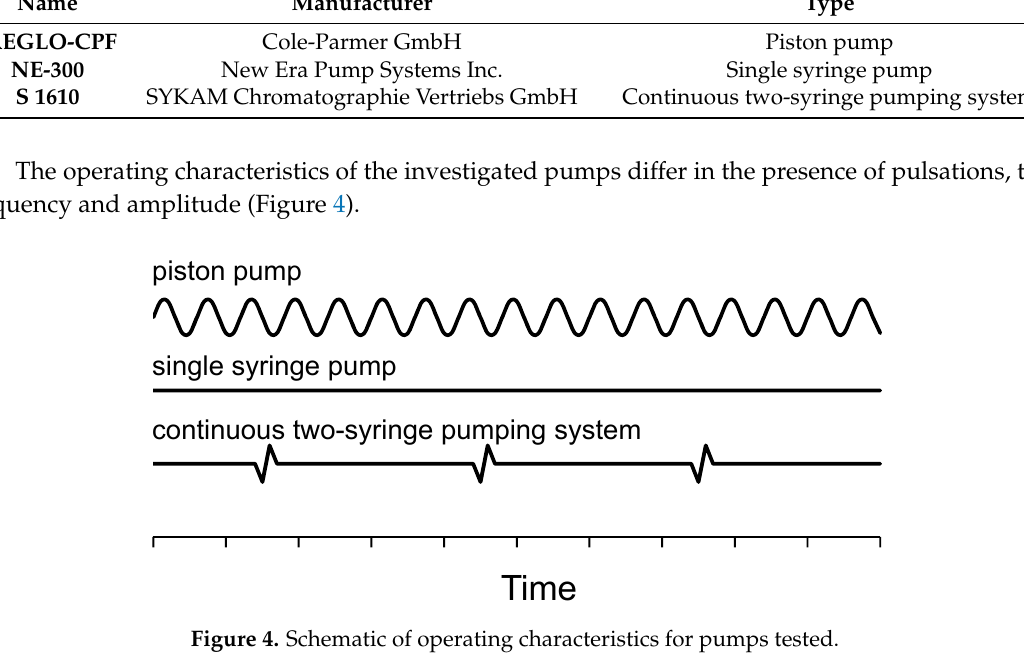
Figure 4. Schematic of operating characteristics for pumps tested.